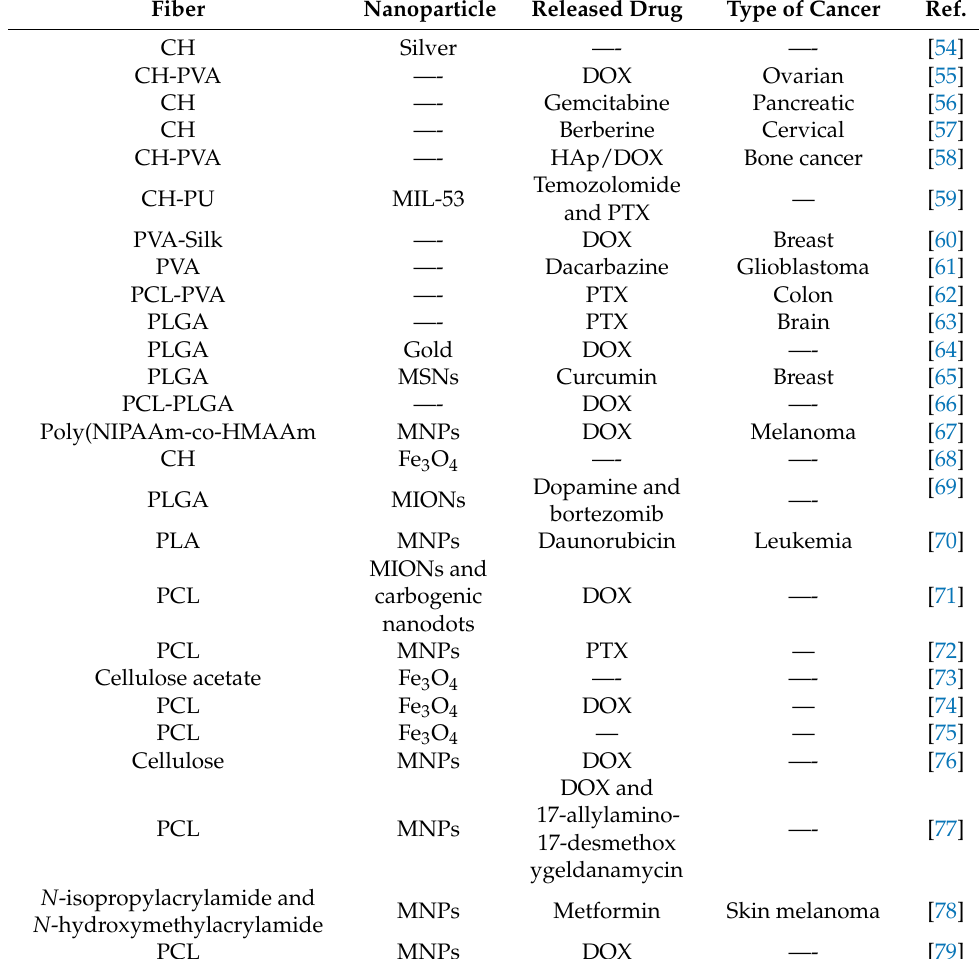
Table 1. Drug delivery systems for cancer treatment.